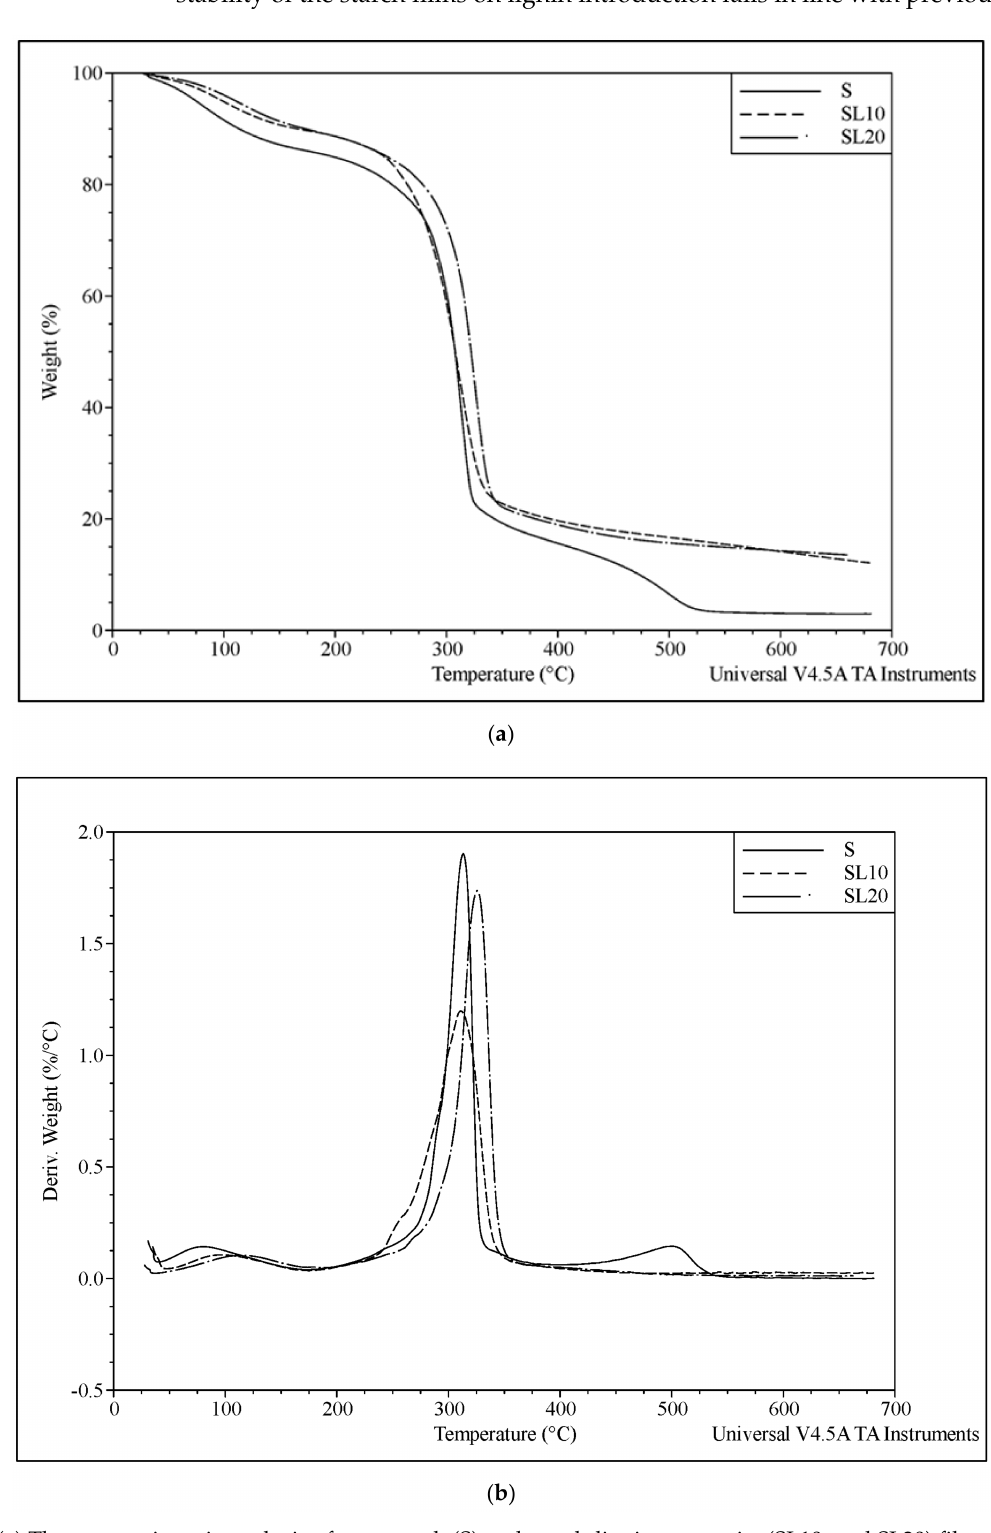
Figure 5. ( a ) Thermogravimetric analysis of neat starch (S) and starch-lignin composite (SL10, and SL20) films at different number of grinding cycles. ( b ) Derivative thermogravimetric analysis of neat starch (S) and starch-lignin composite (SL10, and SL20) at different number of grinding